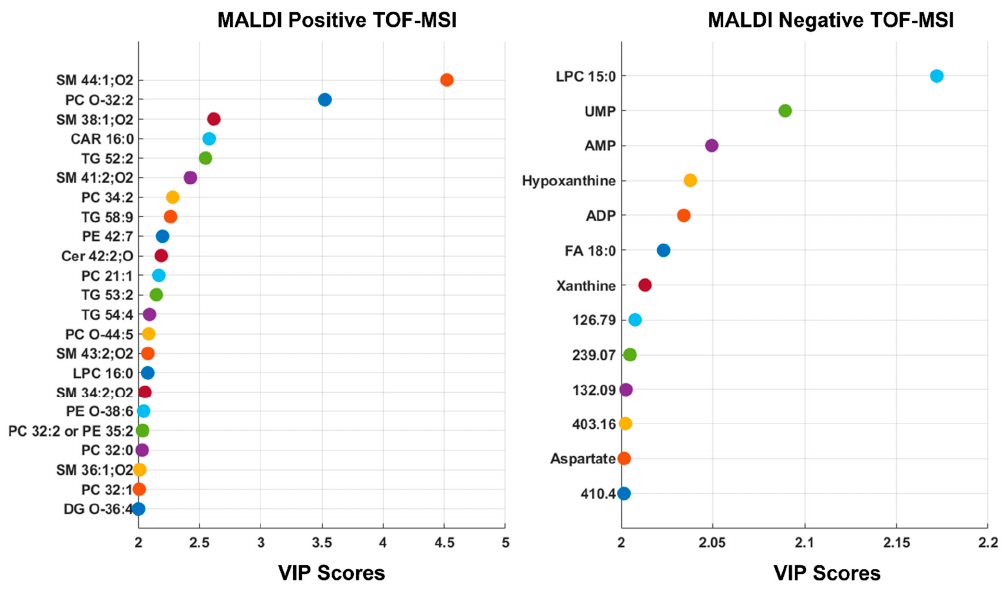
Figure 2. Partial least squares-discriminant analysis (PLS-DA) of MALDI-positive and -negative TOF-MSI data. Graphical illustration of the most relevant predictors for the models built on positive (left) and negative (right) ion mode MSI analyses based on their values of the variable importance in projection (VIP) index, using as threshold a VIP score > 2. Table 1. Partial least squares-discriminant analysis (PLS-DA) of MALDI-positive and -negative TOF-MSI data. Classification results in training, leave-one-patient-out cross-validation, and test steps. The models were applied to the images. Sensitivity and specificity refer to the healthy classes. Abbreviations: CV, cross-validation; nVar, number of variables; nLVs, number of latent variables.